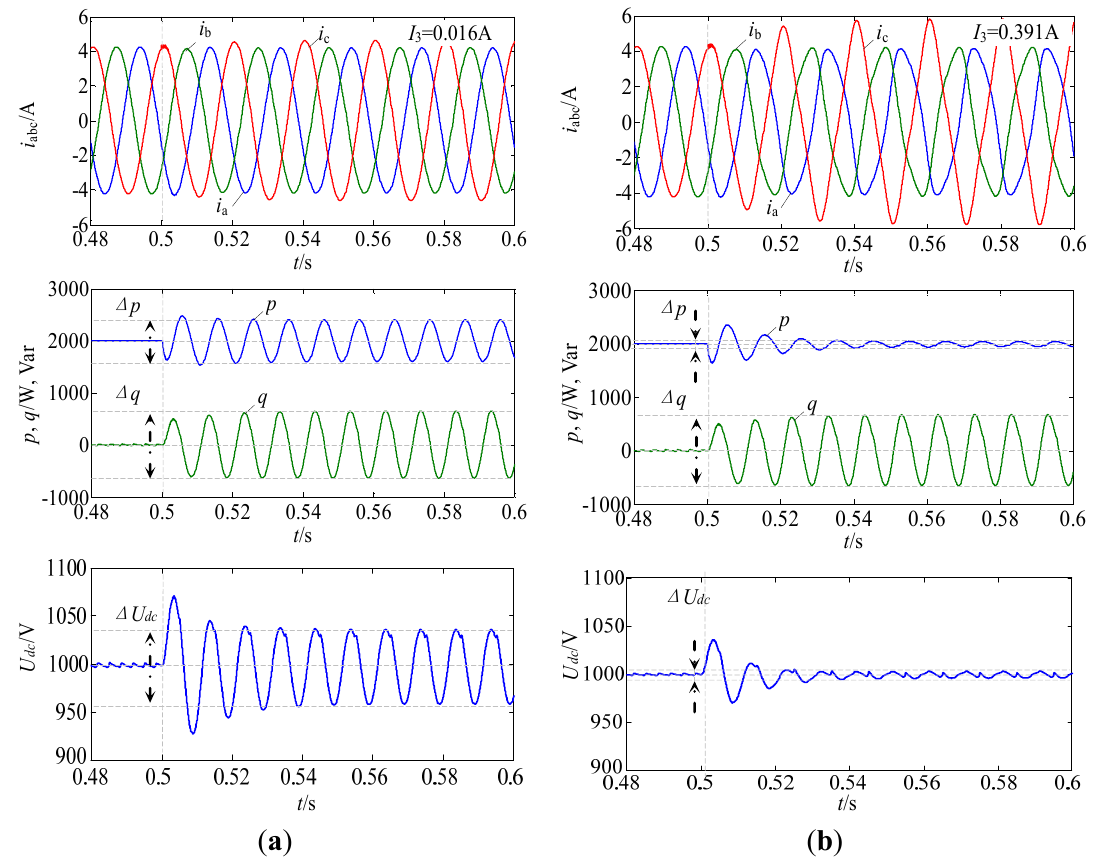
Figure 6. Operation characteristics of photovoltaic generation using control mode I: ( a ) I 3r = 0.004 pu and Δ Q r = 0.3 pu and ( b ) I 3r = 0.1 pu and Δ Q r = 0.3